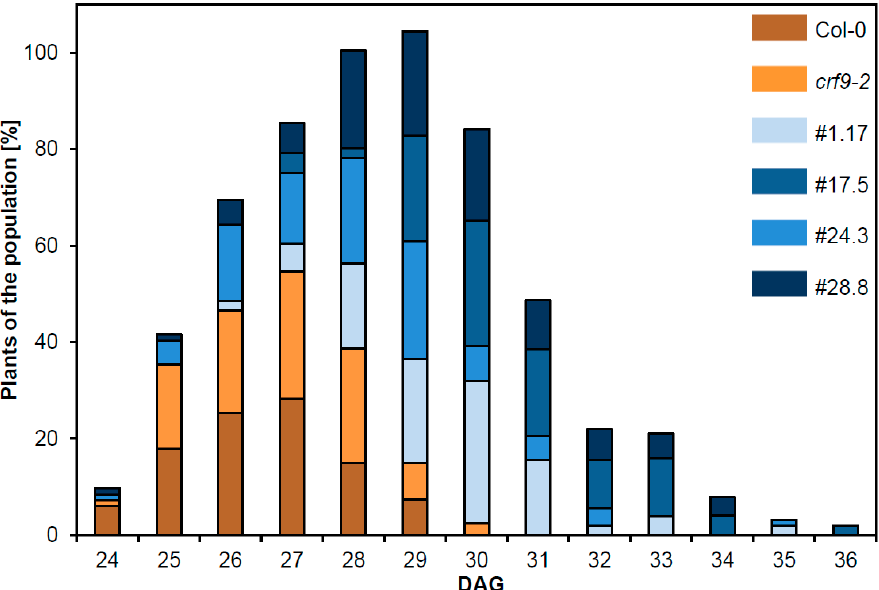
Figure 6. Overexpression of CRF9 causes delayed transition from vegetative to reproductive growth. Plants of the different lines ( crf9-2 , the four CRF9 overexpressing lines, and wild-type plants) were grown in the greenhouse under long-day conditions. The transition from vegetative to reproductive growth was determined as the time between germination and the time point when the stem was 1 cm in height ( n ≥